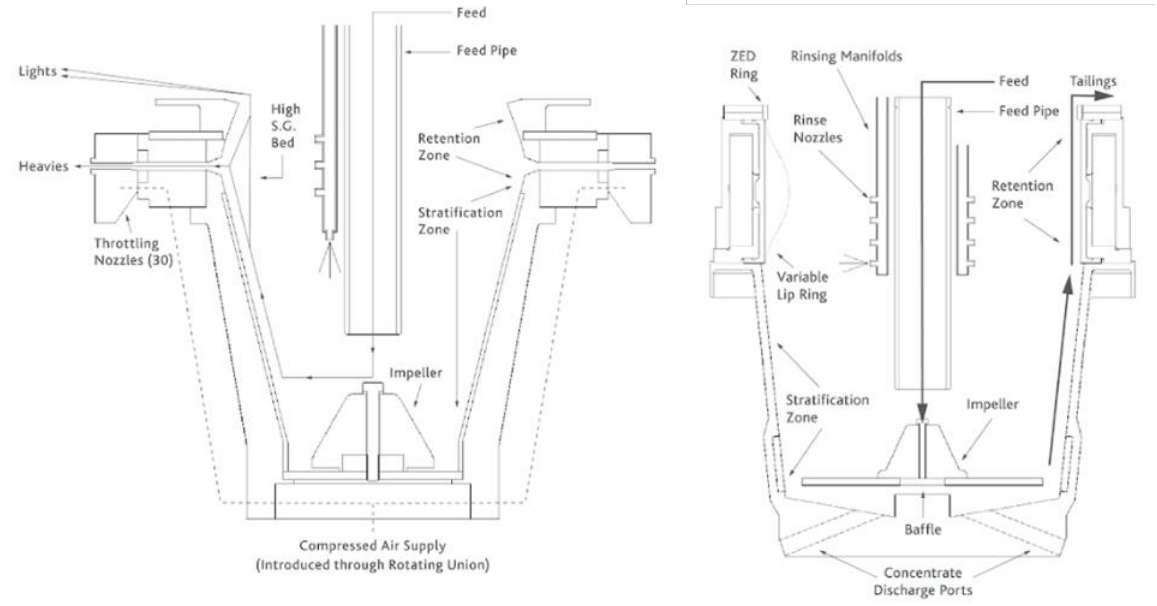
Figure 3. Cross sections of bowl of continuous (left) and UF Falcon (right) [5].